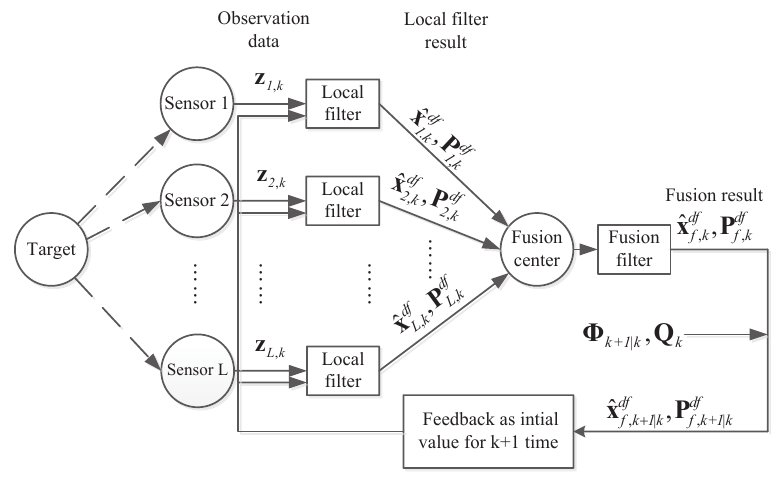
Figure 3. The process of distributed multi-sensor fusion system with